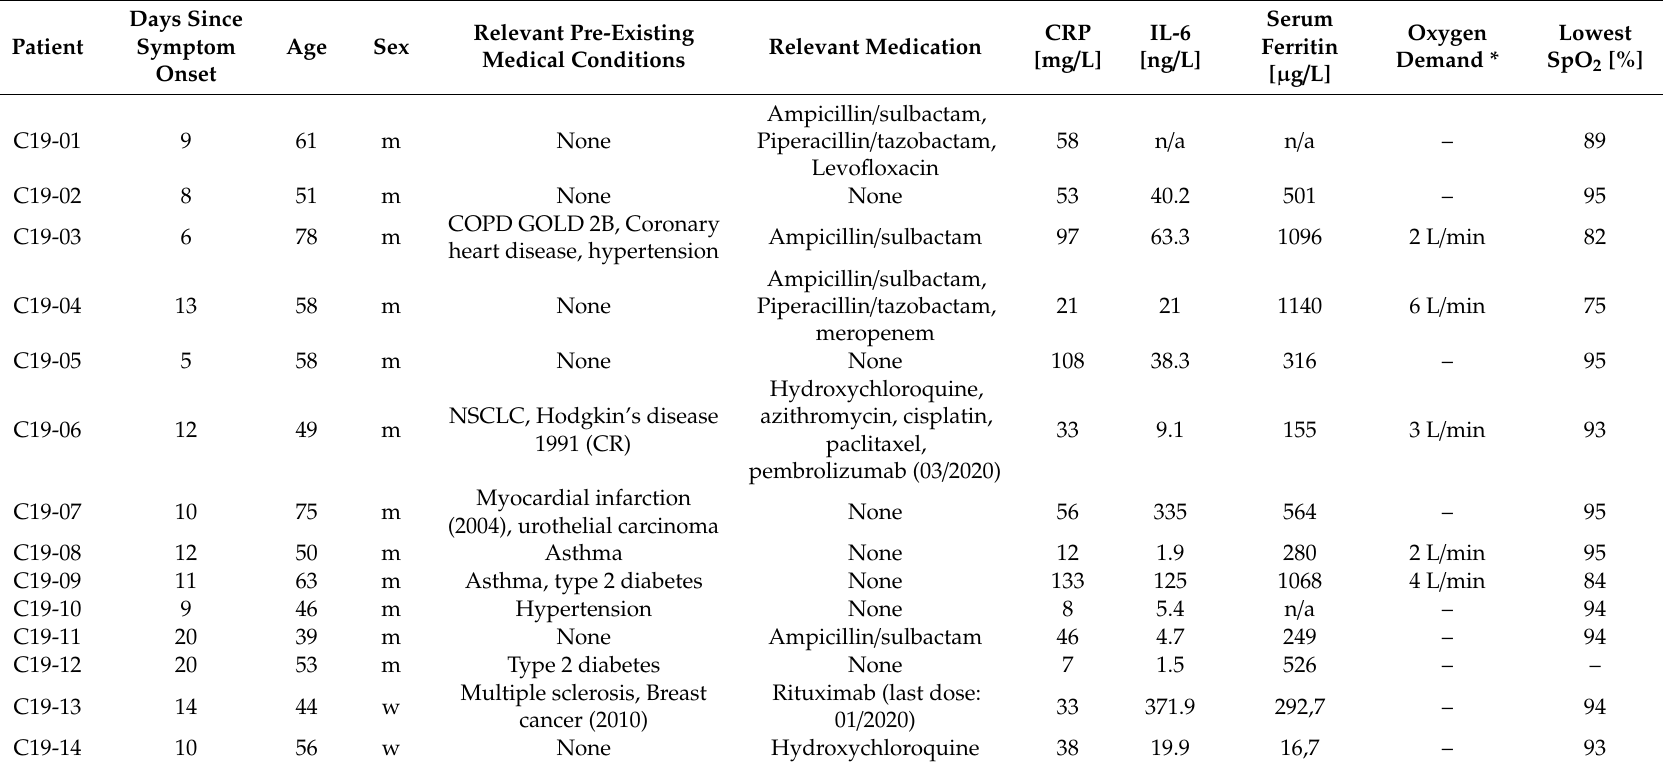
Table 1. Demographic and laboratory patient